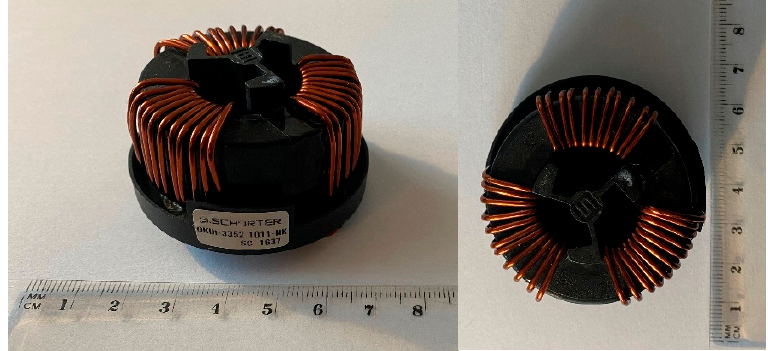
Figure 3. Investigated coupled inductor.